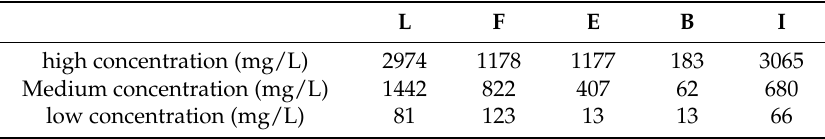
Table 2. Amount of Alcohols Added to Aromatic Recombination for Sensory